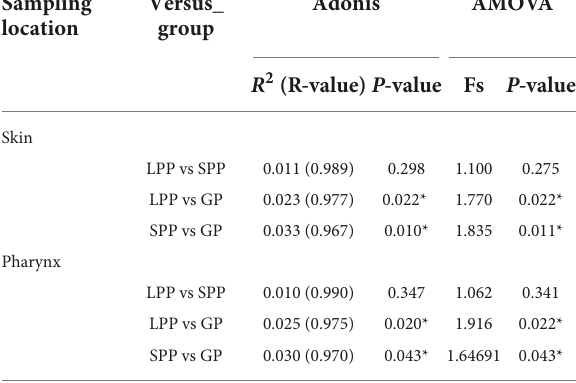
TABLE 2 Adonis and Amova analyses based on unweighted UniFrac distance. Sampling